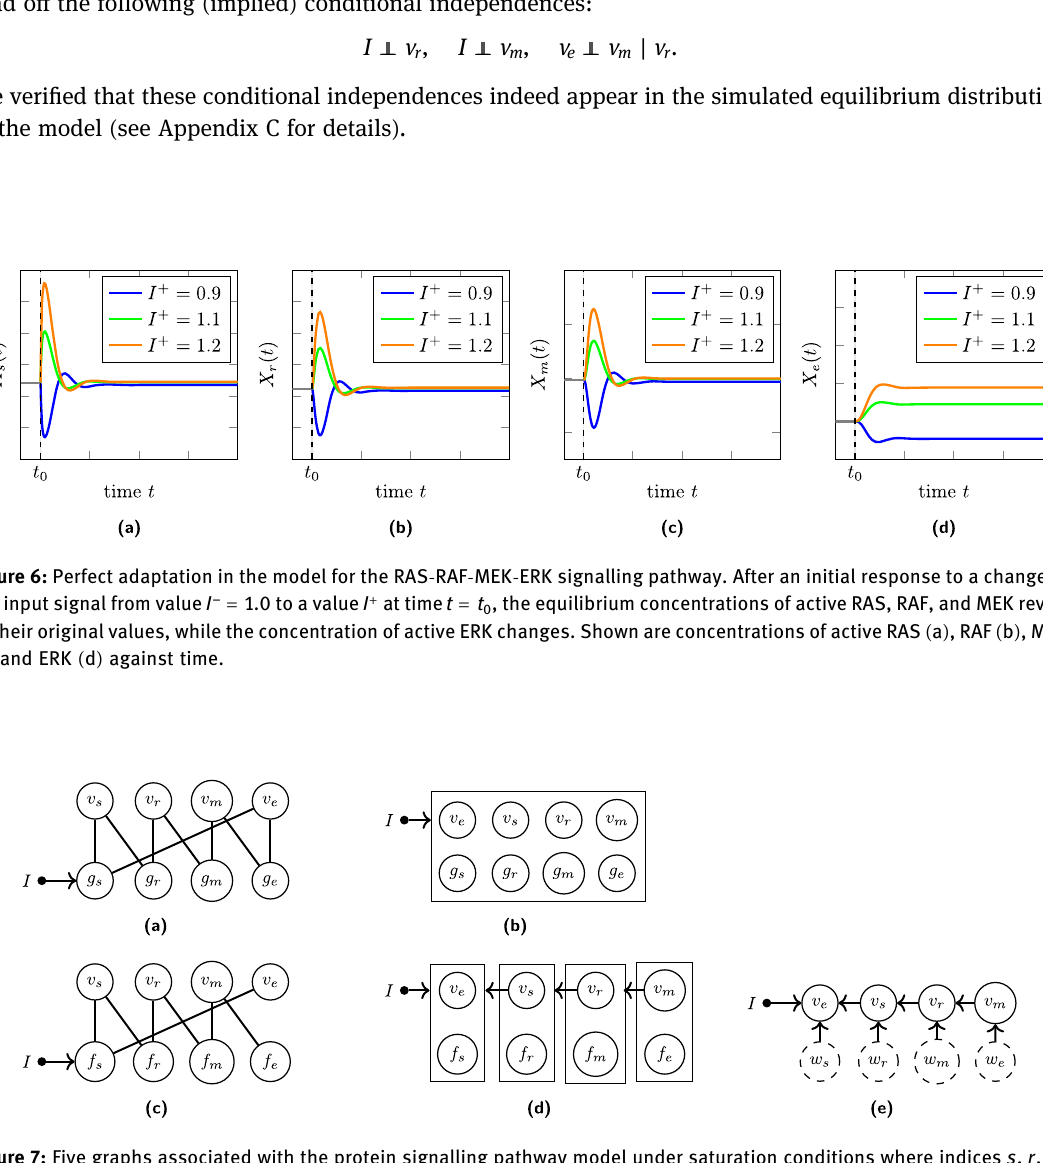
Figure 7: Five graphs associated with the protein signalling pathway model under saturation conditions where indices s r m , , , and e correspond to concentrations of active RAS, RAF, MEK, and ERK, respectively. ( a ) Dynamic bipartite graph. ( b ) Dynamic causal ordering graph. ( c ) Equilibrium bipartite graph. ( d ) Equilibrium causal ordering graph. ( e ) Equilibrium Markov ordering graph.